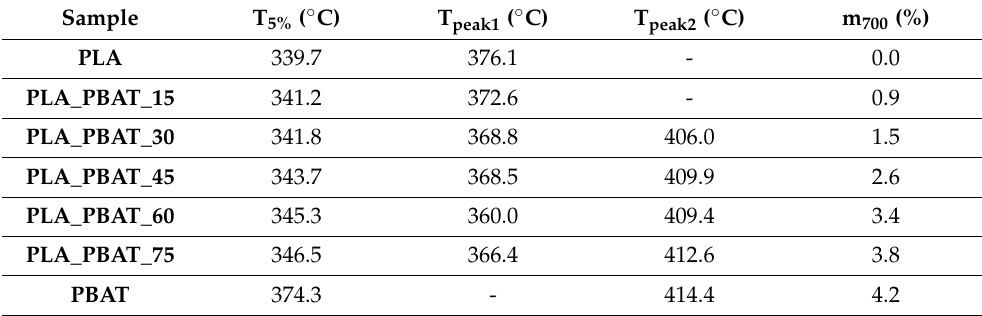
Table 2. Results of the TGA tests on neat PLA, neat PBAT and their blends.